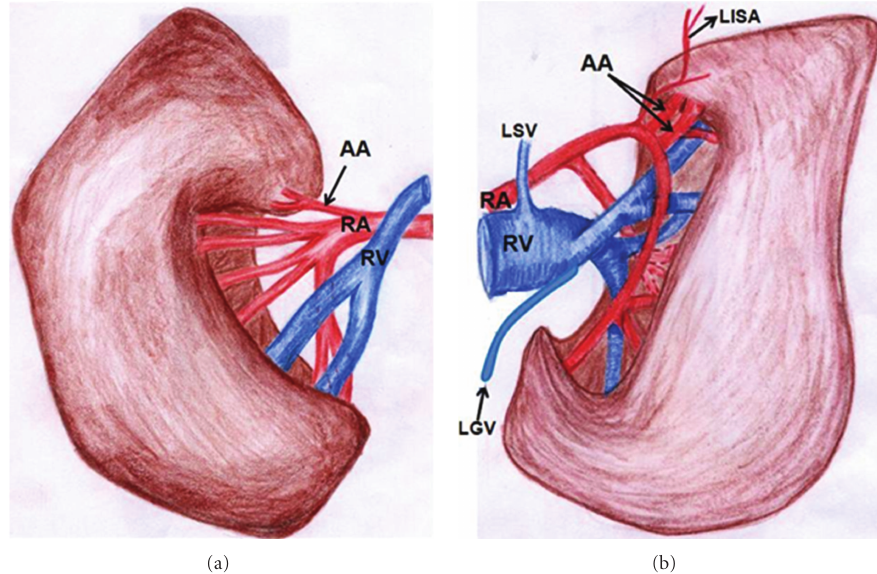
Figure 4: Schematic representation of bilateral renal hilar pattern with distorted shapes of kidneys. AA: aberrant artery, RA: renal artery, RV: renal vein, LGV: left gonadal vein, LSV: left suprarenal vein, and LISA: left inferior suprarenal artery.